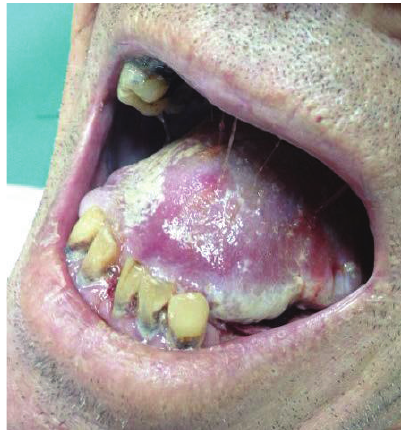
Figure 1: Case one: endophytic tumor lesion with poorly defined